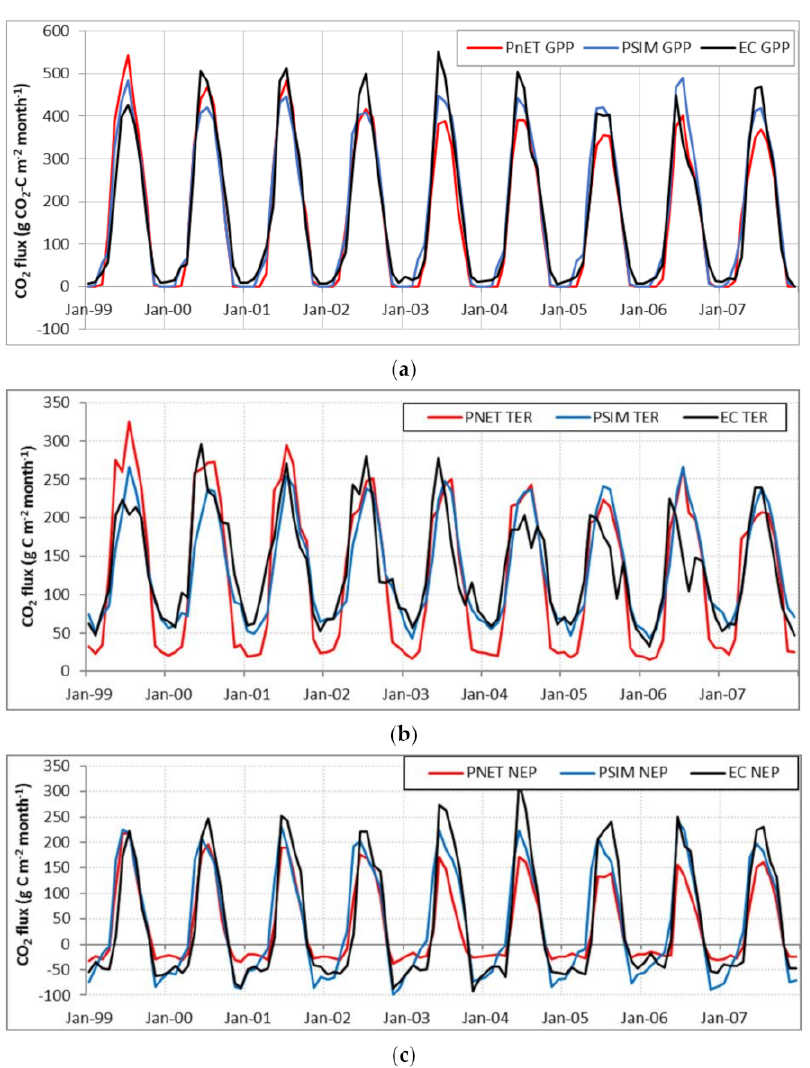
Figure 3. Monthly CO 2 fluxes at the Straits Inclosure simulated by PSIM and PnET and measured by eddy covariance (EC): ( a ) GPP, ( b ) TER, ( c )